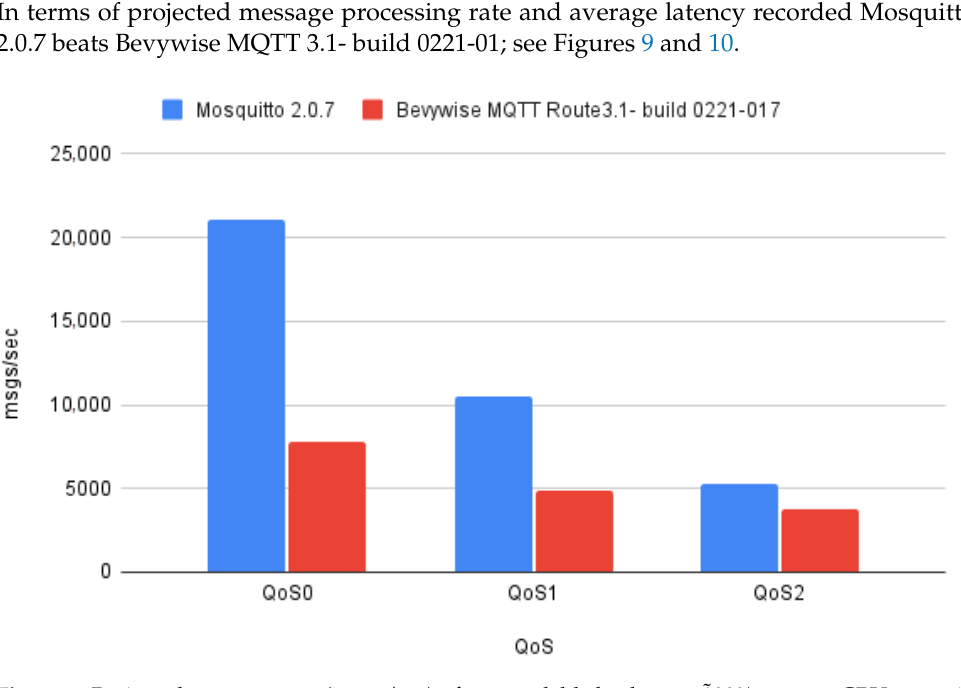
Figure 9. Projected message rate (msgs/sec) of non-scalable brokers at ˜100% process CPU usage in the cloud evaluation environment.